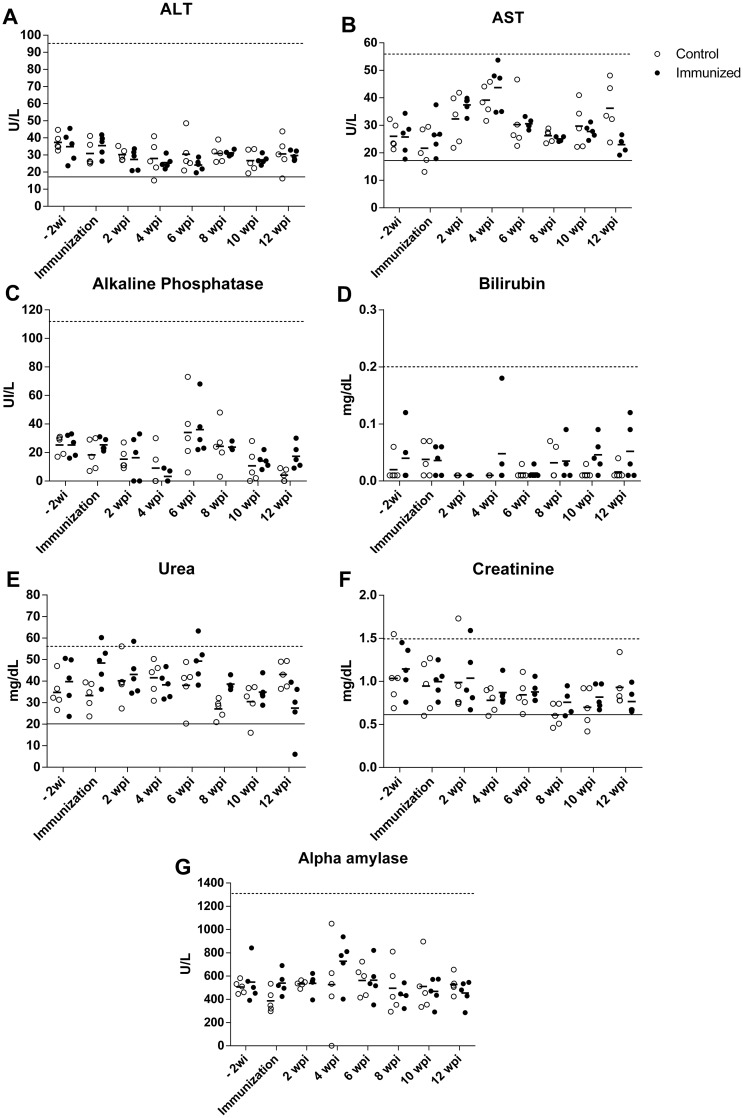
Biochemical parameters of hepatic, renal, and pancreatic functions of dogs immunized with alginate-encapsulated B. ovis ΔabcBA (immunized) or inoculated with sterile capsules of alginate (control).Horizontal lines indicate the mean value of ALT (alanine aminotransferase) (A), AST (aspartate aminotransferase) (B), alkaline phosphatase (C), total bilirubin (D), urea (E), creatinine (F), and alpha amylase (G) measured by colorimetric analysis. Individual values are represented by open dots for Control and closed dots for Immunized dogs. Reference values are indicated by a dashed line (S2 Table).